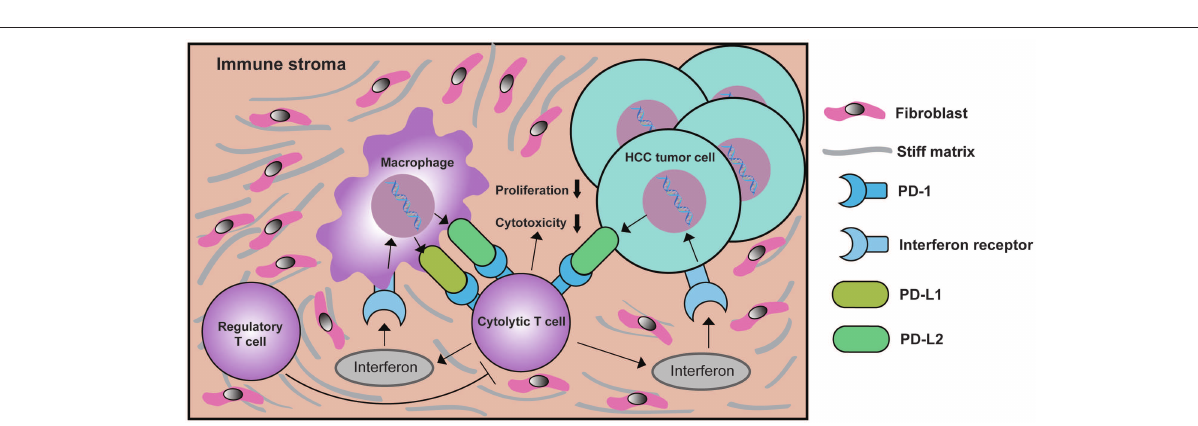
FIGURE 8 | Schematic depiction of the mechanisms underlying PD-Ls-mediated cytolytic T cell exhaustion in the HCC microenvironment. In response to interferon γ signaling activated by cytolytic T cell, macrophages in immune stroma up-regulate PD-L1 and/or PD-L2 expression. At the same time, the expression of PD-L2 on HCC tumor cell membranes is also increased. The ligation of PD-Ls in macrophage and HCC tumor cells with PD-1 will down-modulate the function of cytolytic T cells, eventually creating a negative feedback loop that inhibits the proliferation and cytotoxicity of cytolytic T cells, thus reducing antitumor immunity. During this process, the function of regulatory T cell (Treg) is enhanced, which further suppresses the function of cytolytic T